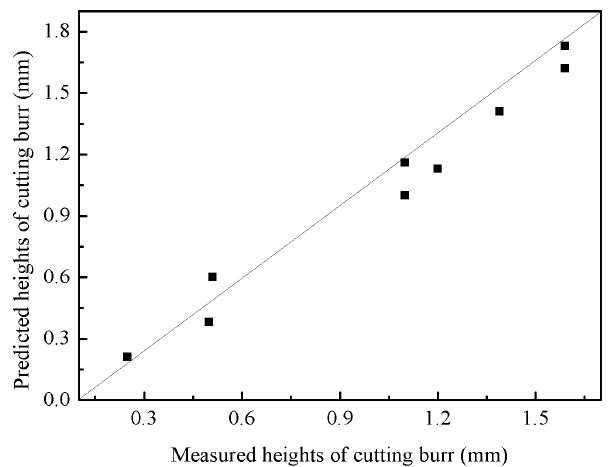
Figure 15. The diagram of measured cutting burr and predicted cutting burrs for the testing data